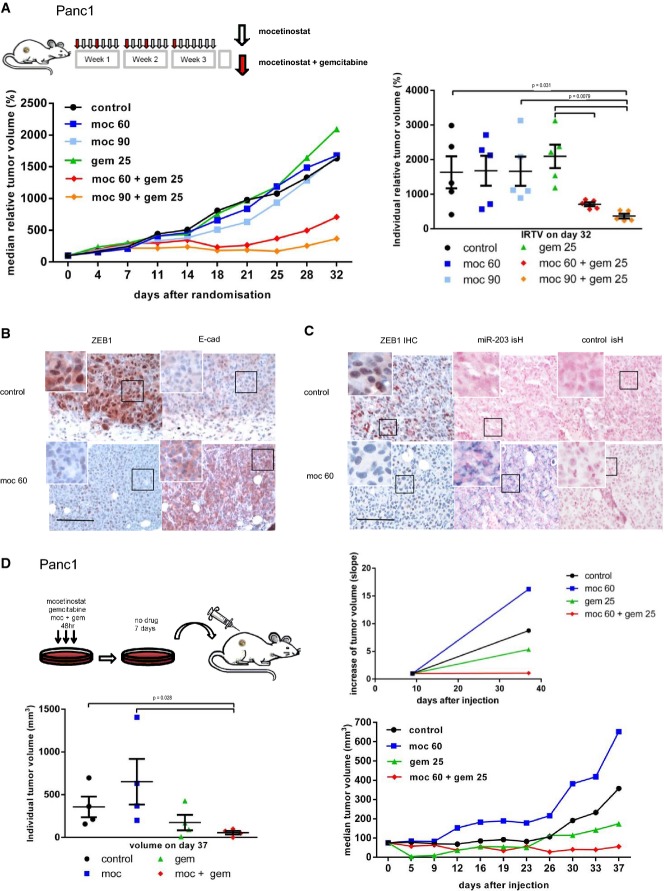
Mocetinostat sensitizes to gemcitabine in vivo

Relative tumor volume (RTV) of Panc1-derived tumors in NMRI nu/nu mice. Eleven days after implantation, mice were randomized according to tumor volume. Treatment with mocetinostat (60 or 90 mg/kg/day) and gemcitabine (25 mg/kg/day) was implemented (day 0) as depicted in the scheme. Shown are the group medians of the RTVs over time (left) and the individual RTVs on day 32 (right). n = 5 for each treatment group; nonparametric Mann–Whitney U-test.

Representative immunohistochemical stainings of serial sections showing reduced ZEB1 and increased E-cadherin in tumor tissues of mice treated with mocetinostat. Scale bar 40 μm, inserts for higher magnifications 10 μm. Squares indicate magnified regions.

Representative pictures of in situ hybridization for miR-203 and control probe showing gain of miR-203 and associated loss of ZEB1 detected by immunohistochemistry in serial sections of mocetinostat-treated xenograft tumors. Scale bar 40 μm, inserts for higher magnifications 5 μm. Squares indicate magnified regions.

Schematic outline and results for xenografts of ex vivo treated Panc1 in Foxn1 nude mice. Panc1 cells were pre-treated with mocetinostat (1 μM) and/or gemcitabine (50 nM) for 48 h, followed by a 7-day recovery period before being injected subcutaneously (left). Equal numbers of viable cells were injected in 75 μl volume. At day 9 after injection, tumor growth was detectable in all groups (lower right). To better visualize and compare tumor growth, the tumor volume at day 9 was set to 1 and the increasing slope of the tumor volume to day 37 is depicted (upper right). The individual absolute tumor volumes on day 37 (lower left) and the group medians of the absolute tumor volumes over time (lower right) are shown. For cells pre-treated with the combination of mocetinostat and gemcitabine, tumor growth was arrested. n = 4 for each treatment group; nonparametric Mann–Whitney U-test.